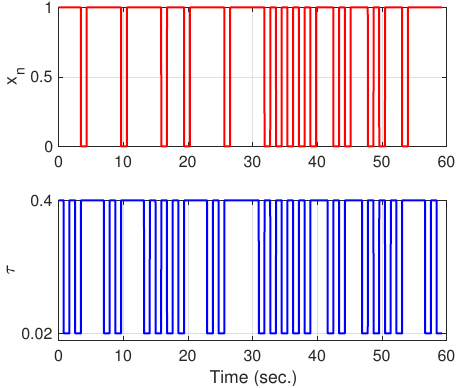
Figure 4. Random time delay model. The values of random variable x n determine the time delay τ . The maximum delay is set at h = 0.4